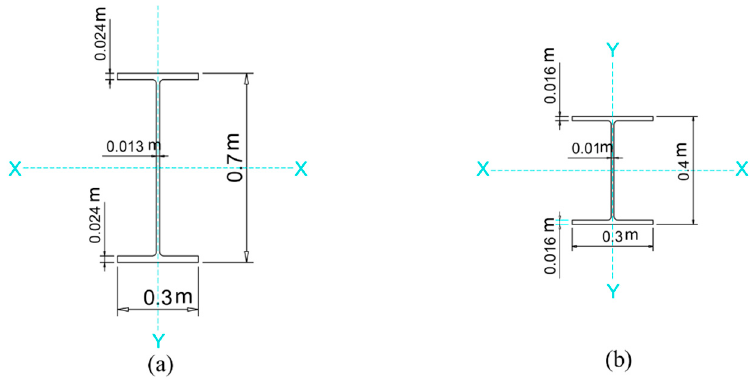
Figure 5. Two-dimensional model of the building with a fender structure.